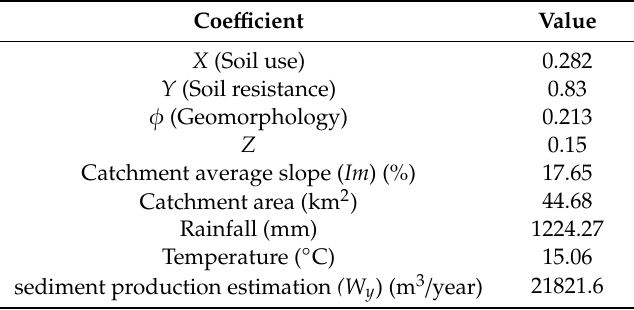
Table 3. Coe ffi cient and parameters used for the estimation of sediment production in the Savuto Lake